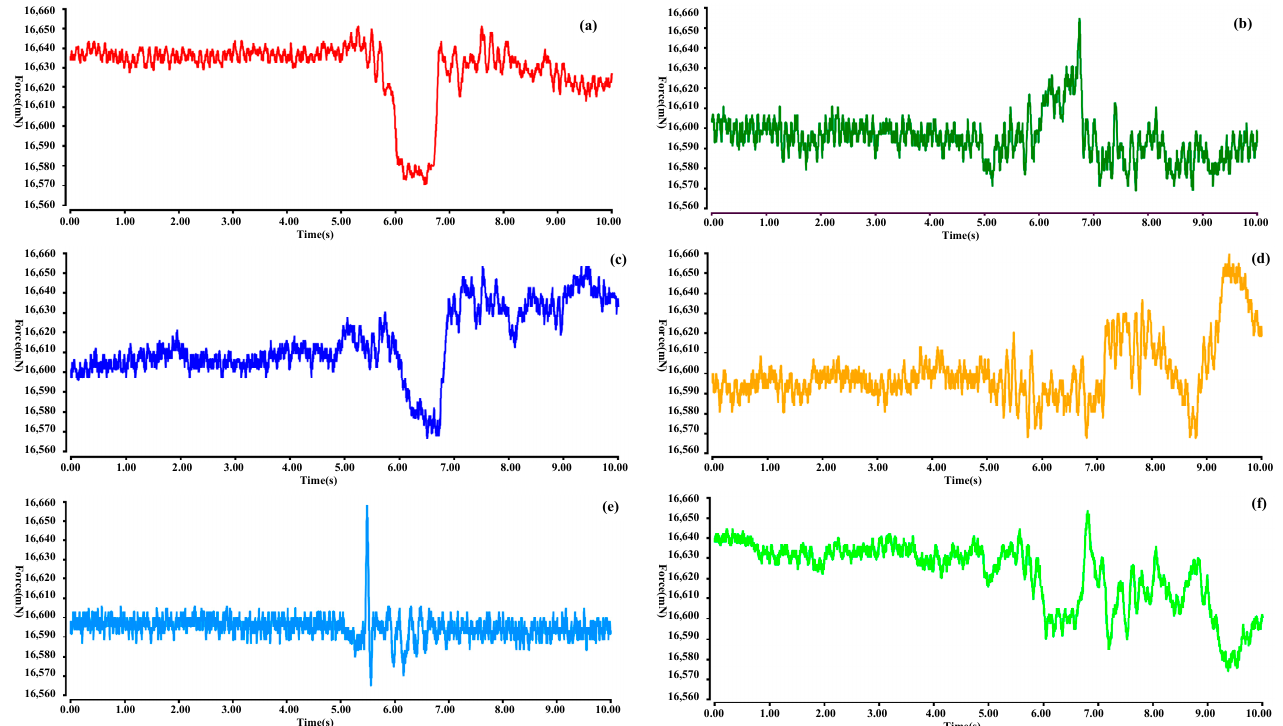
Figure 18. Force curve at the end of six electric cylinders during docking, and figures ( a – f ) represent No. 1–6 electric cylinders.